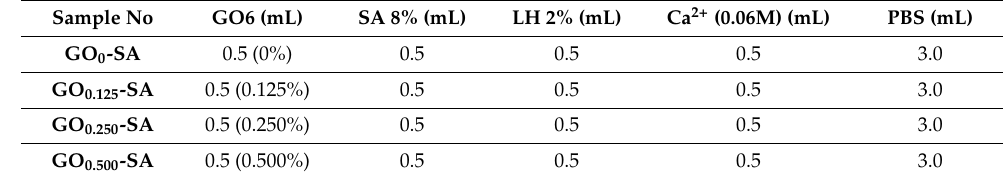
Table 2. The compositions of hydrogel samples before testing aqueous